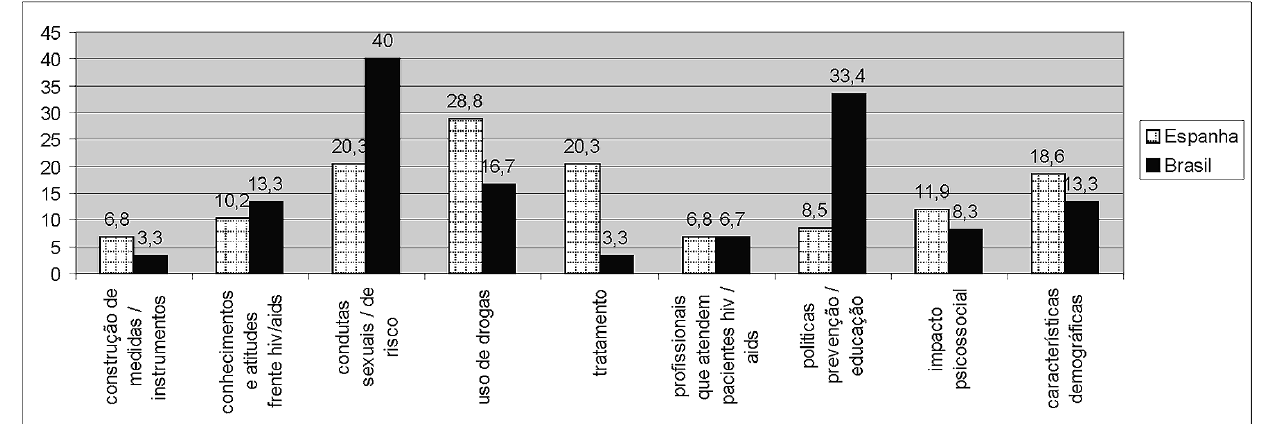
Figura 7. Principais assuntos investigados dentro do tema HIV/Aids.